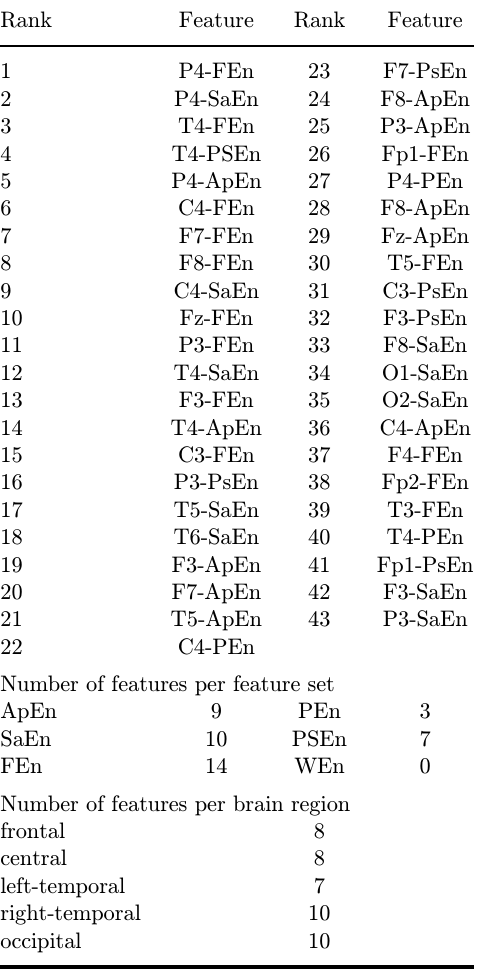
Table 4. Top 43 salient features selected by an AUC curve based feature selection algorithm.